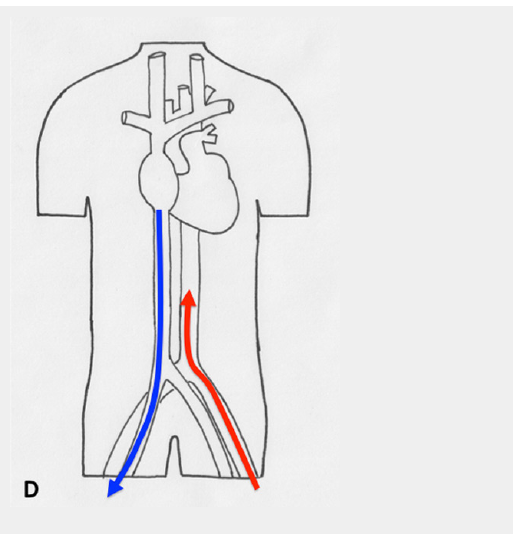
Different types of cannulation for venovenous and venoarterial cannulation. (A) Femorofemoral venovenous extracorporeal life support (VV ECLS) cannulation modality, with drainage cannula just underneath of the junction between the inferior vena cava and right atrium. The inflow cannula is positioned in the right atrium. (B) Venoatrial VV ECLS cannulation modality, where the drainage cannula is positioned just underneath the right atrium. The inflow cannula is placed via the internal jugular vein with its tip just in front of the tricuspid valve. (C) Standard central cannulation for ECLS, here the drainage device is depicted positioned in the femoral vein. Of note is that from the aspect of support this does not show any difference compared with the device being in right atrium. (D) Femorofemoral AV ECLS cannulation modality, with drainage device in the inferior vena cava and the inflow cannula in contralateral femoral